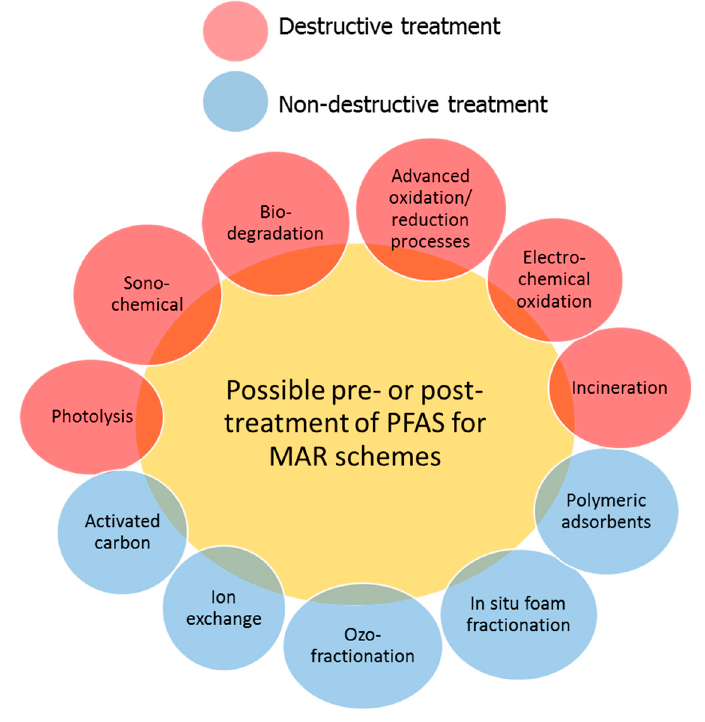
Figure 2. Possible PFAS pre-treatment or post-treatment technologies for MAR schemes (modified after Ross et al., [49]).